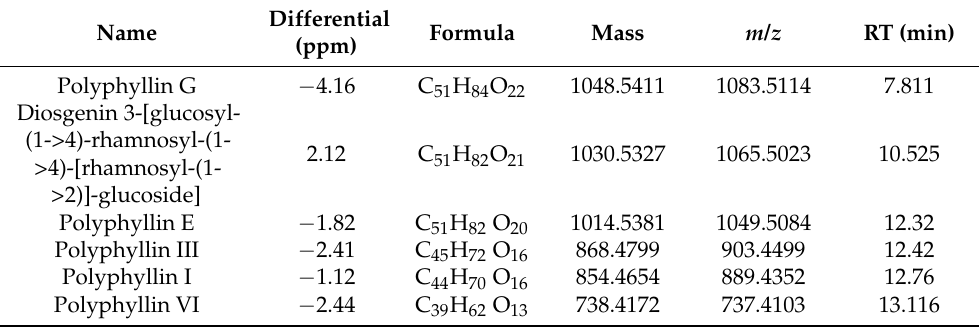
Table 5. Mass spectral characteristics and tentative identification of anticancer compounds present in PPE using HR-LCMS in negative